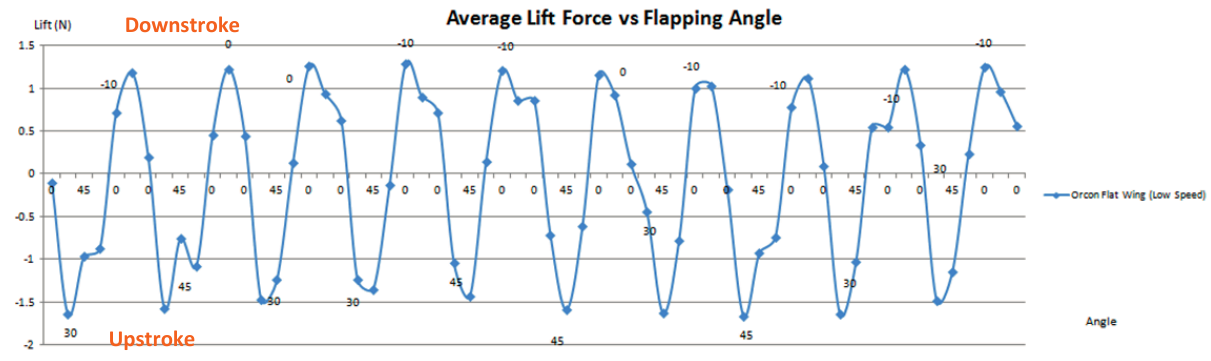
Figure 39. Orcon flat wing lift against time (10 full cycles).